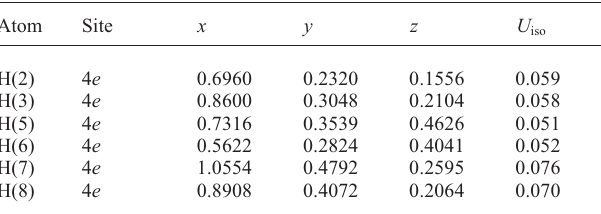
Table 2. Atomic coordinates and displacement parameters (in Å 2 )